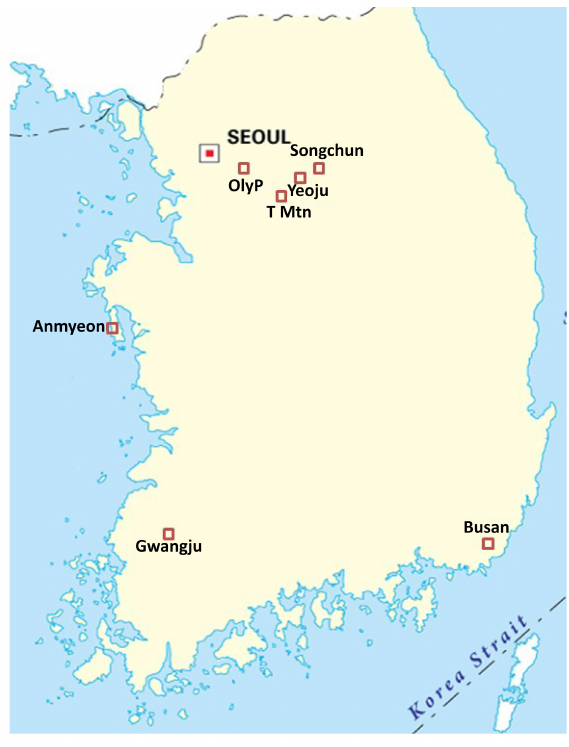
Figure 1. KORUS-AQ sites for nine Pandora instruments at eight